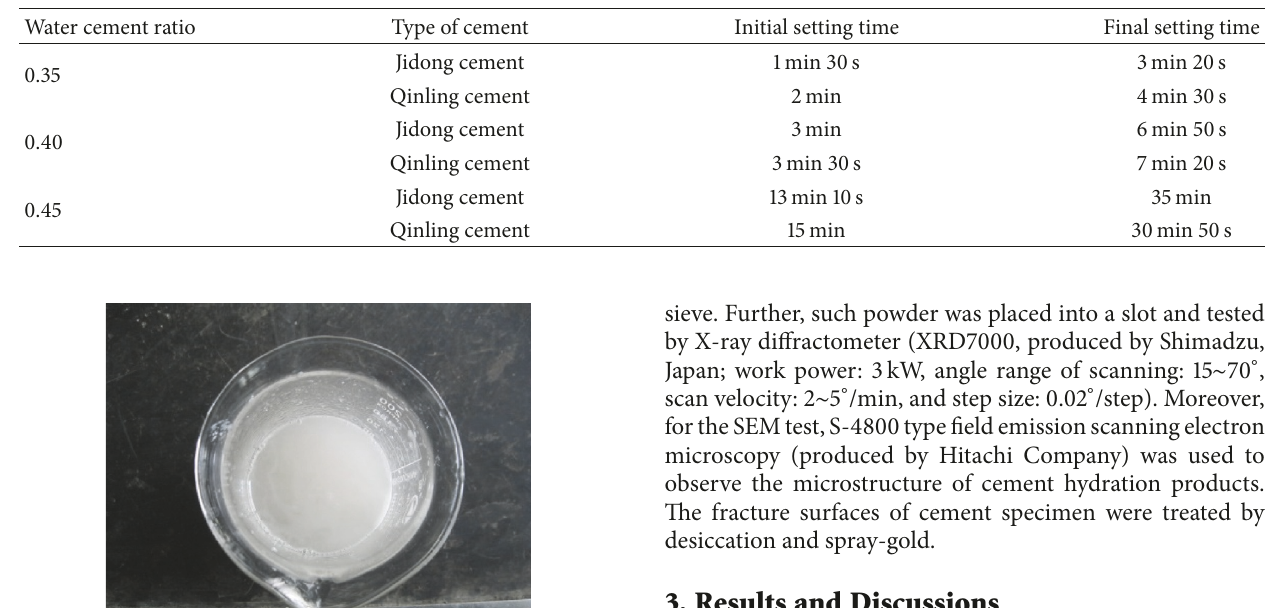
Table 2: The effect of water cement ratios on setting time (20 ± 2 ∘ C).